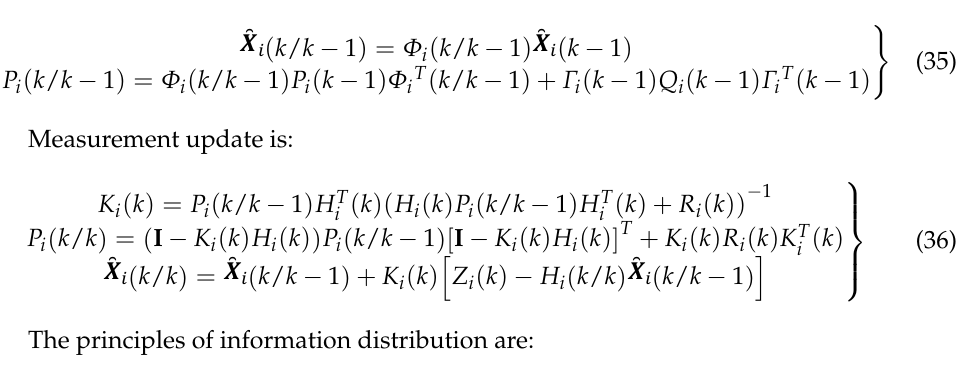
Figure 5. Schematic diagram of main fusion system.